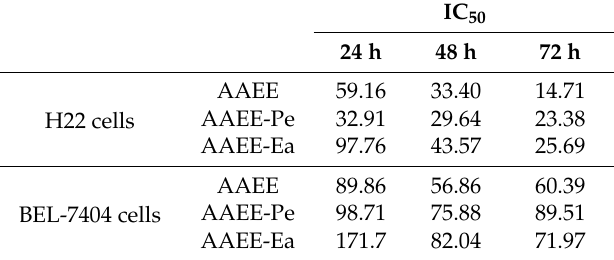
Table 1. IC 50 values of AAEE, AAEE-Pe, and AAEE-Ea for BEL-7404 and H22